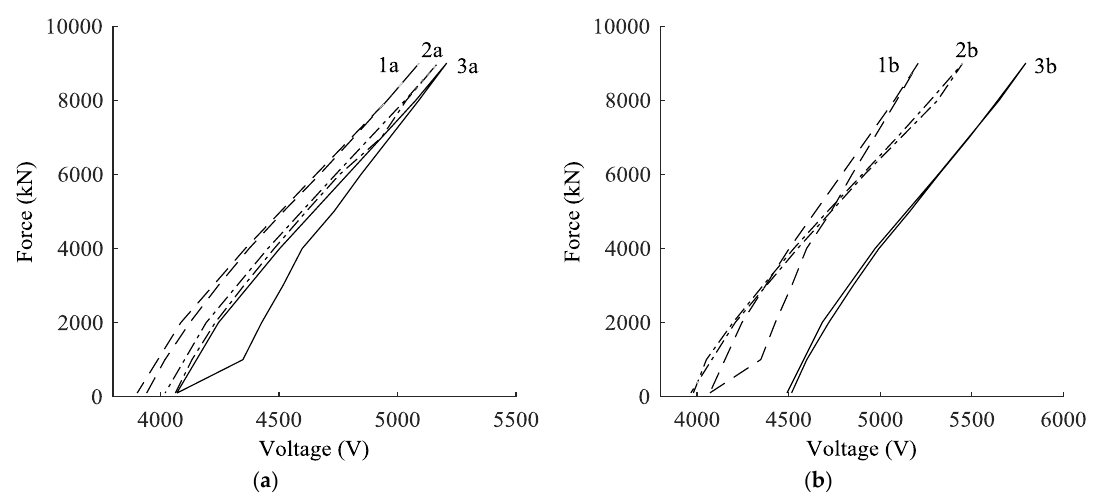
Figure 4. ( a ) different load-voltage calibration curves of the same sensor: the (3a) and (2a) lines are for different load cycles at temperature T = 27.2 °C, while the (1a) line was recorded at temperature T = 37.7 °C; ( b ) force to voltage ratio for three different sensors, after temperature compensation. Table 1. Mean and standard deviation (StD) of coefficients α , a and b identified by laboratory calibration. Cable Diameter (mm)